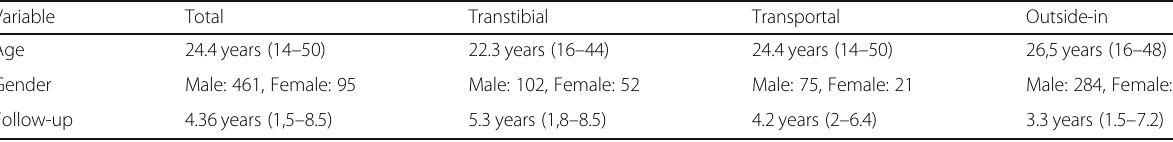
Table 1 Demographic data of the study population